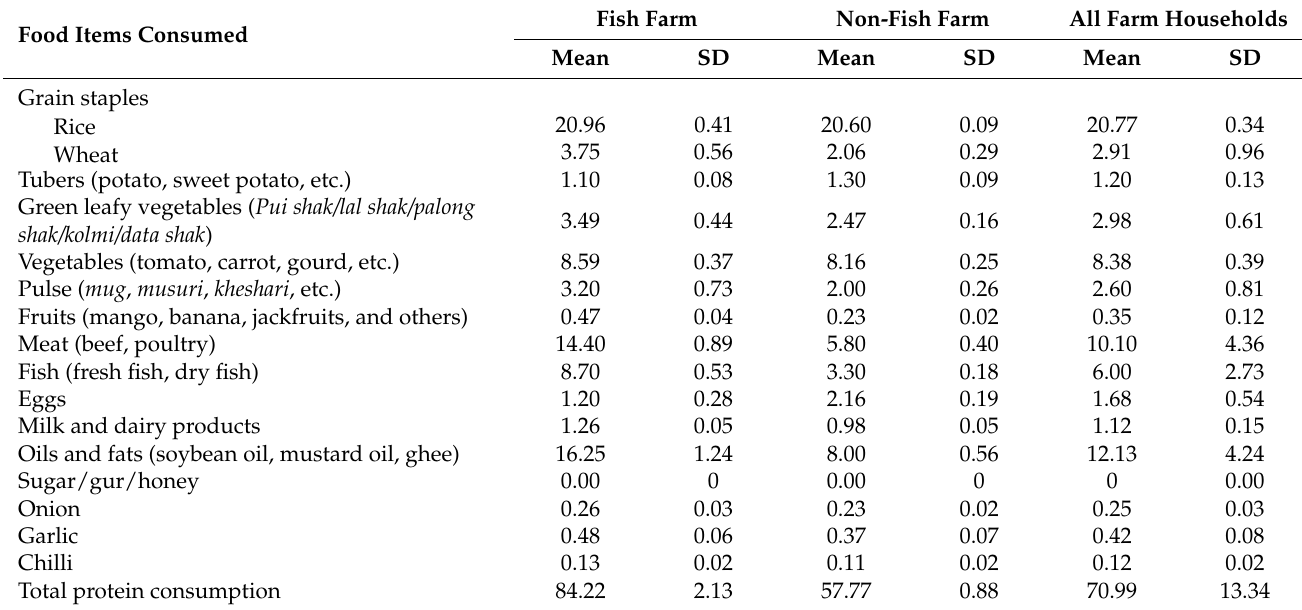
Table 7. Protein intake of food items by fish and non-fish farm household